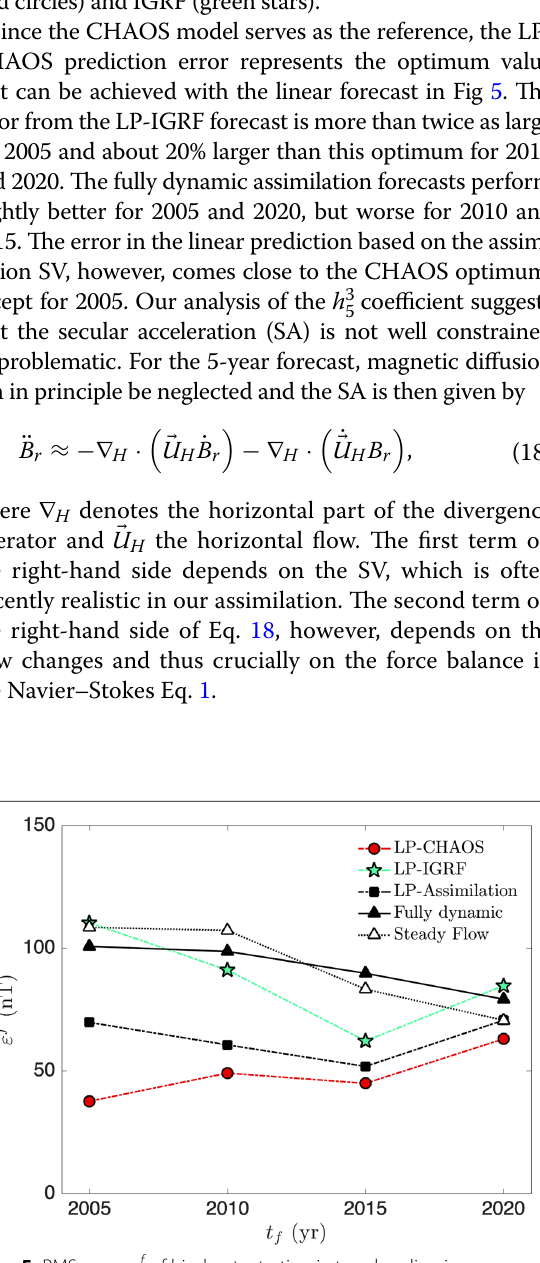
Fig. 5 RMS errors ε f of hindcasts starting in t i and ending in t f = t i + 5 years. The predictions correspond to the full dynamic mean forecast from the assimilation (black triangles) and linear approximations (LP) based on the SV at t i from our mean model (black squares), IGRF (green stars) and CHAOS-7 (red circles). Also shown is the mean forecast error using a steady-flow approximation after the last analysis in t i (white triangles). The prediction errors are truncated at ℓ = 8 and evaluated at the Earth’s surface with